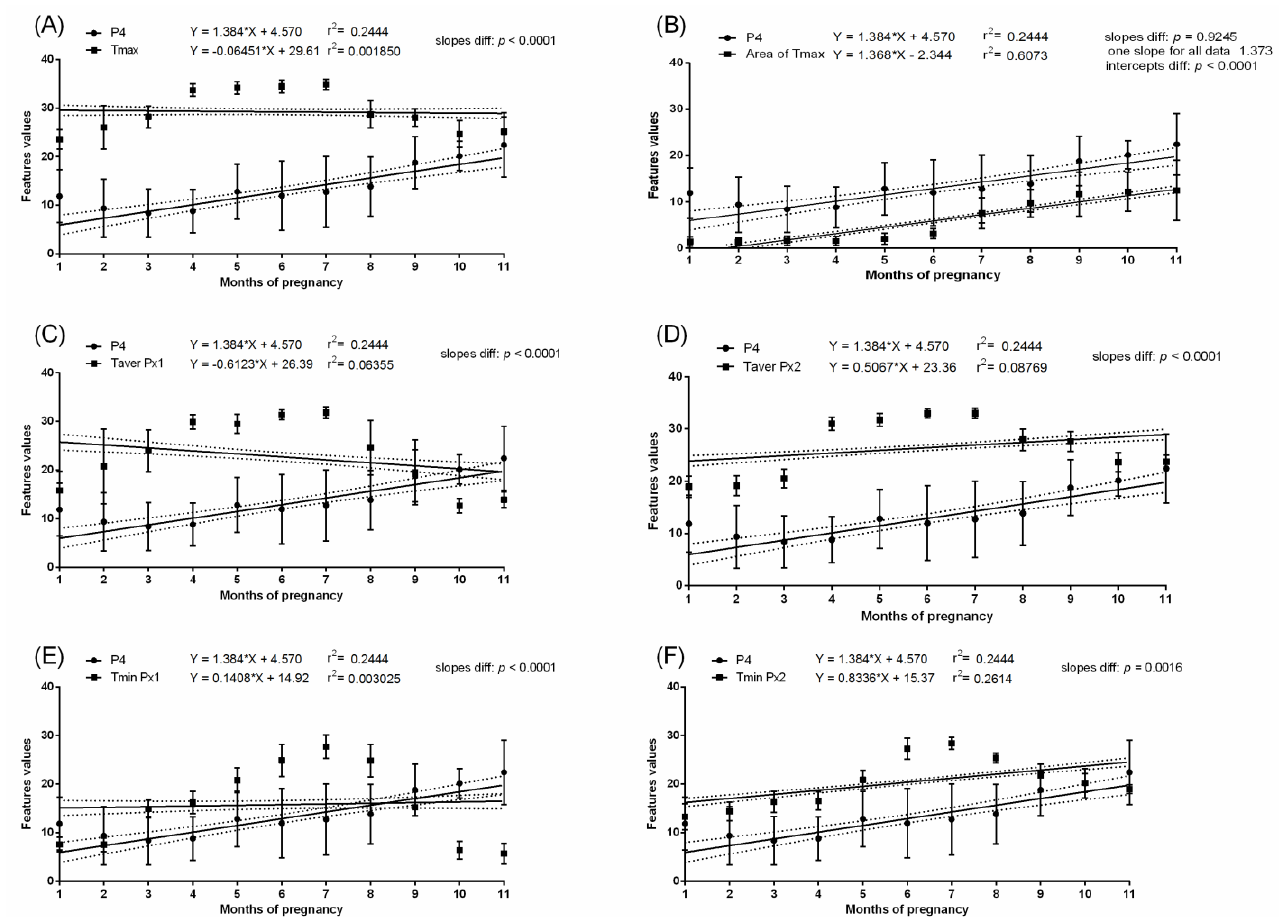
Figure 7. Linear regressions of progesterone concentration in the serum and selected thermal features of the lateral surface of the abdomen in pregnant mares: the maximal temperature in Px1 and Px2 ( A ); the area with the highest temperatures in the range of 3 °C ( B ); the average temperature in Px1 ( C ); the average temperature in Px2 ( D ); the minimal temperature in Px1 ( E ); the minimal temperature in Px2 ( F ).